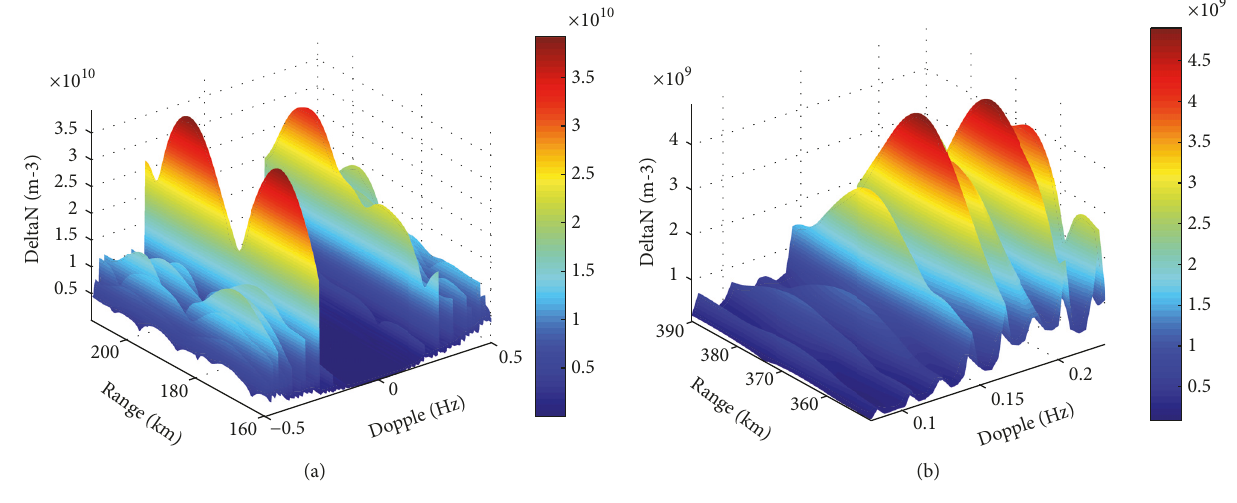
Figure 10: Experimental inversion results: (a) E layer; (b) F